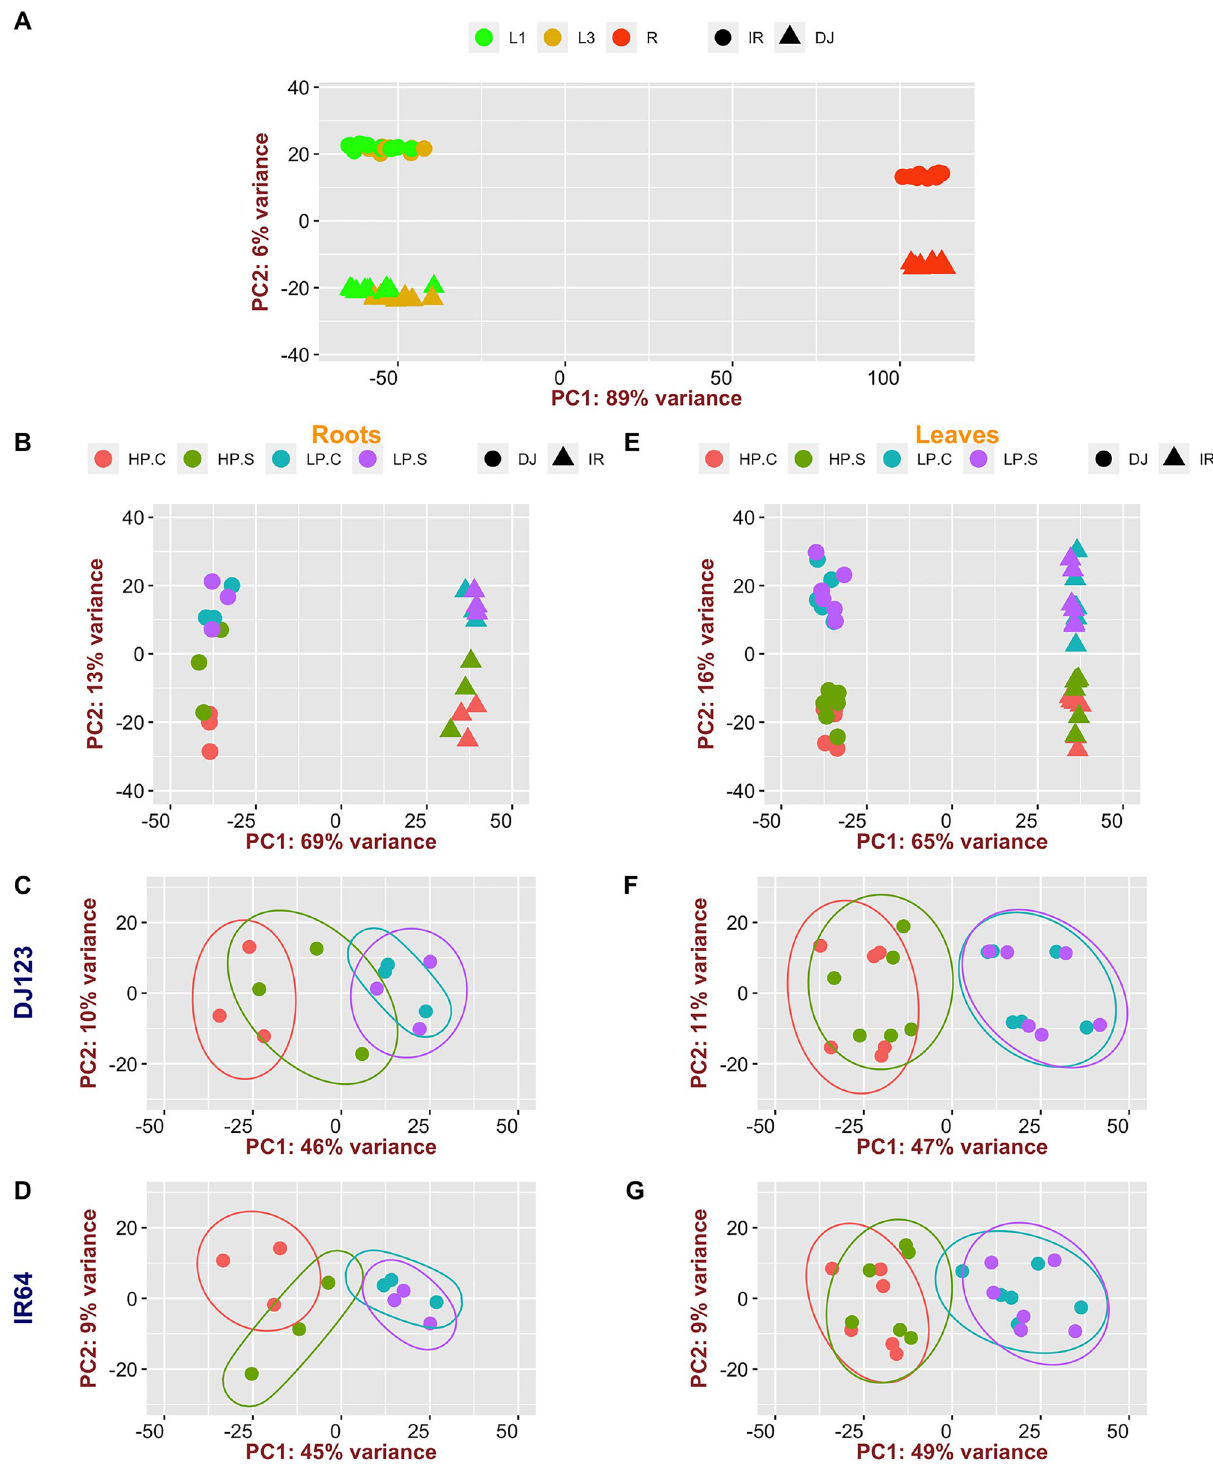
Figure 5. Principal component analysis of the RNA-seq